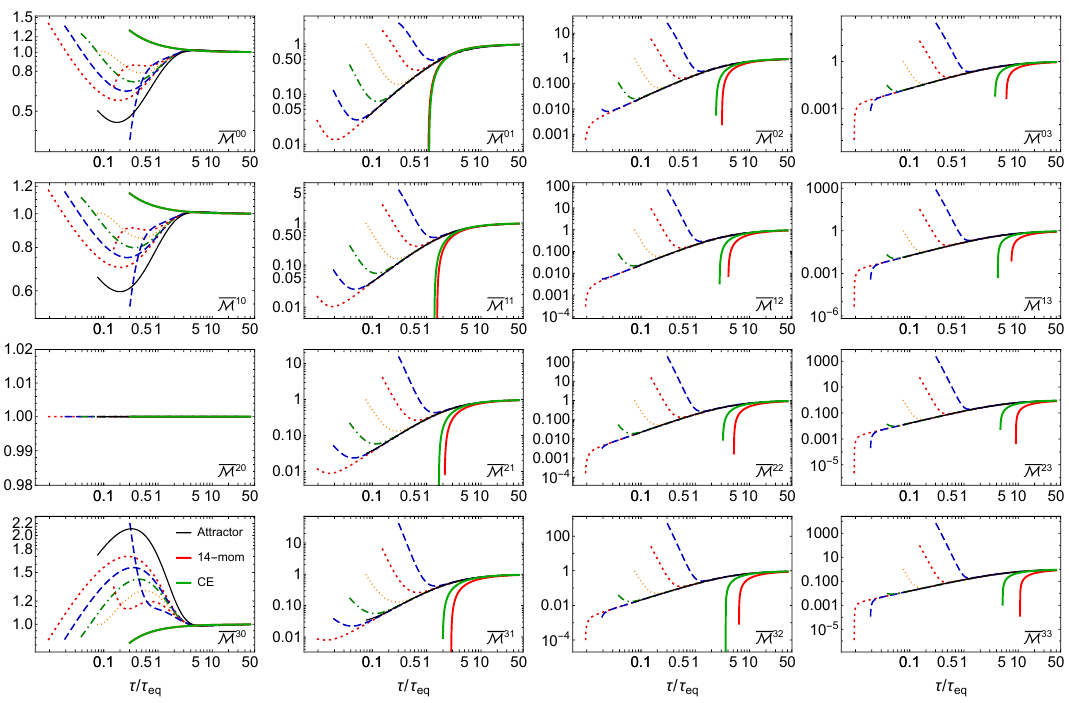
Figure 11 . Scaled moments M nl as a function of rescaled time for the case m = 1 GeV obtained using the generalized spheroidal initial condition specified in eq. (A.1) and varying all parameters appearing therein, ξ 0 , γ 0 , and τ 0 .